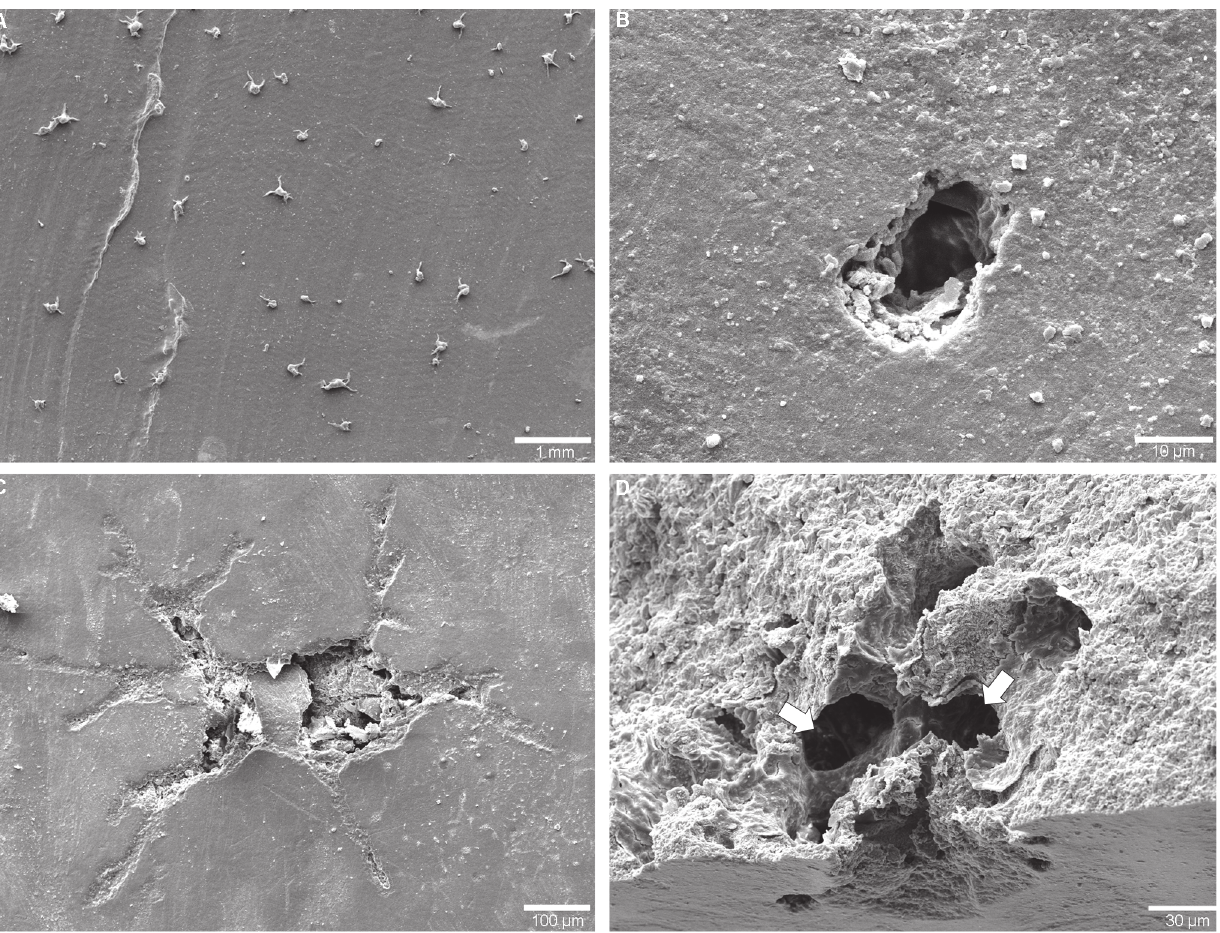
Fig 5. Morphotype 3 in Nautilus macromphalus from New Caledonia as seen in SEM images of epoxy-resin casts. (A) Cluster of traces in an epoxy- resin cast. (B) Photograph of shell surface, showing the entrance pit produced by the foraminifer. (C) Shell surface featuring the mature stage with large main chamber and pronounced rhizoids. (D) Broken shell allowing insight of the cavity produced by the 'naked' foraminifer with organic remains and two chambers